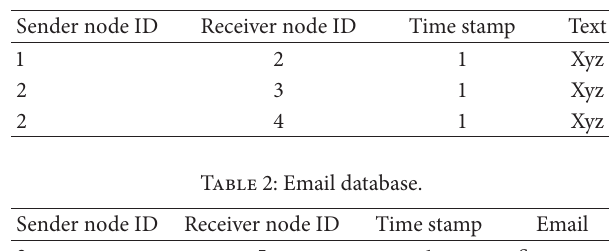
Table 1: SMS database.